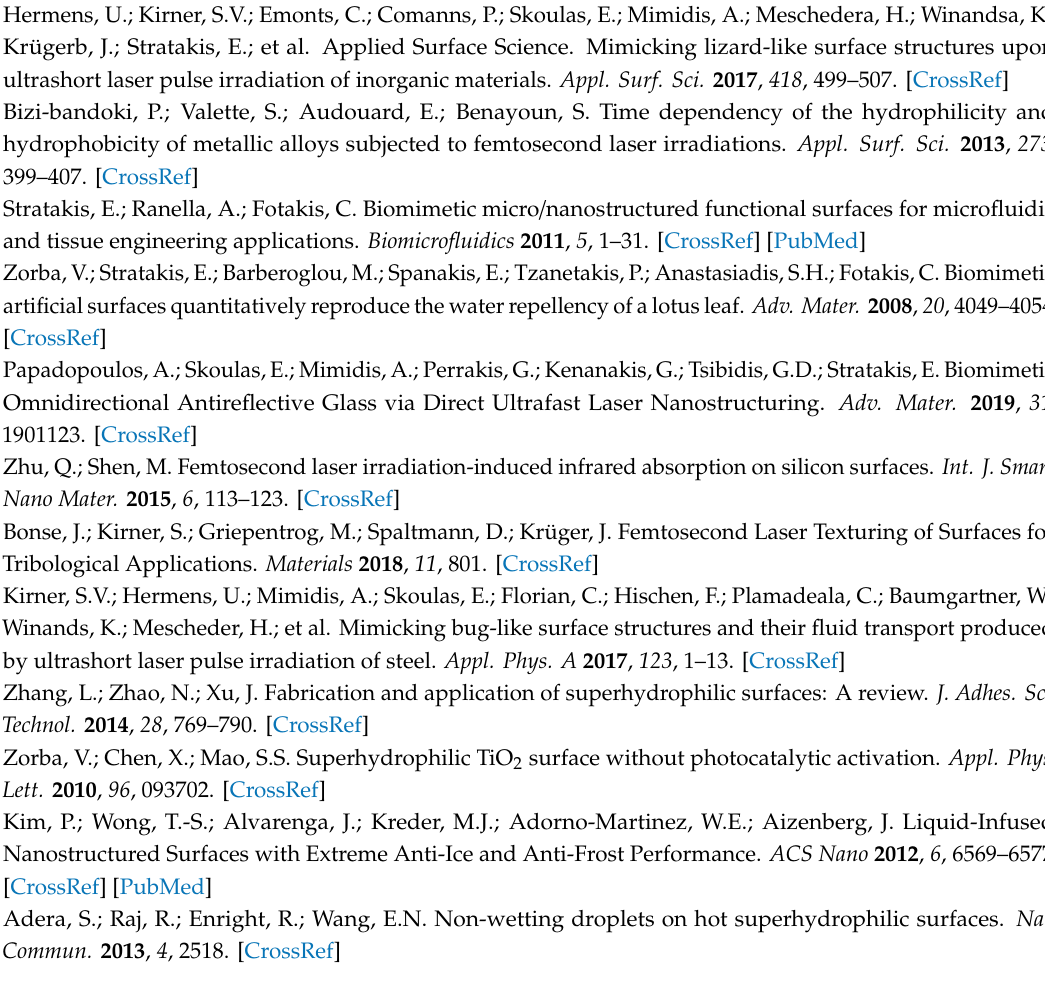
Table S1: Parameters used for laser